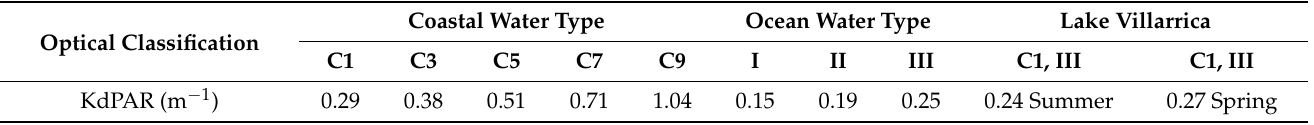
Table 3. Optical classification of Jerlov’s oceanic and coastal water and SD-derived KdPAR for Lake Villarrica. Source: [19].